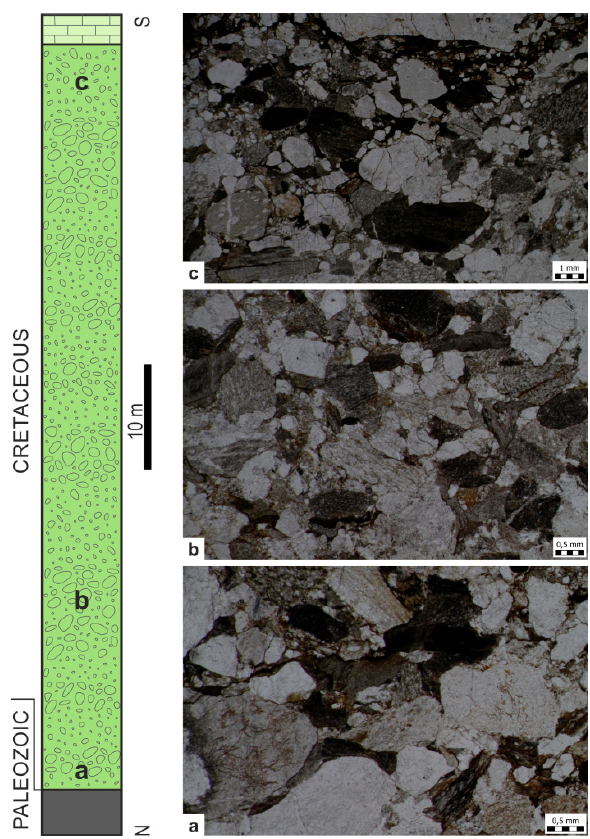
Figure 8. Photomicrographs of conglomerate matrix from Statistic Points 1 ( a ), 2 ( b ) and 3 ( c ) in transmitted light. Position of sampling points shown on a schematic column.